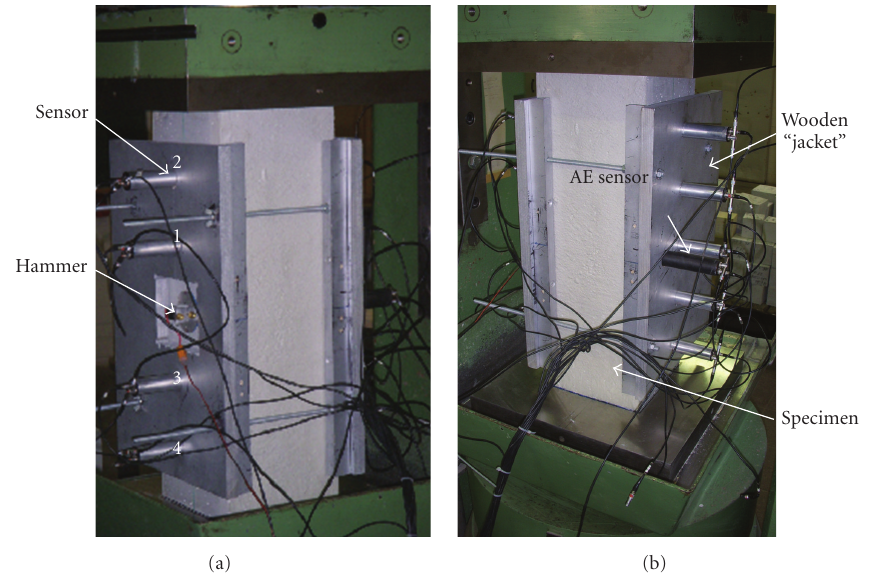
Figure 3: Measurement setup: (a) the sensor arrangements for surface wave velocity measurements, (b) the five extra sensors on the opposite side of the specimen and the additional AE